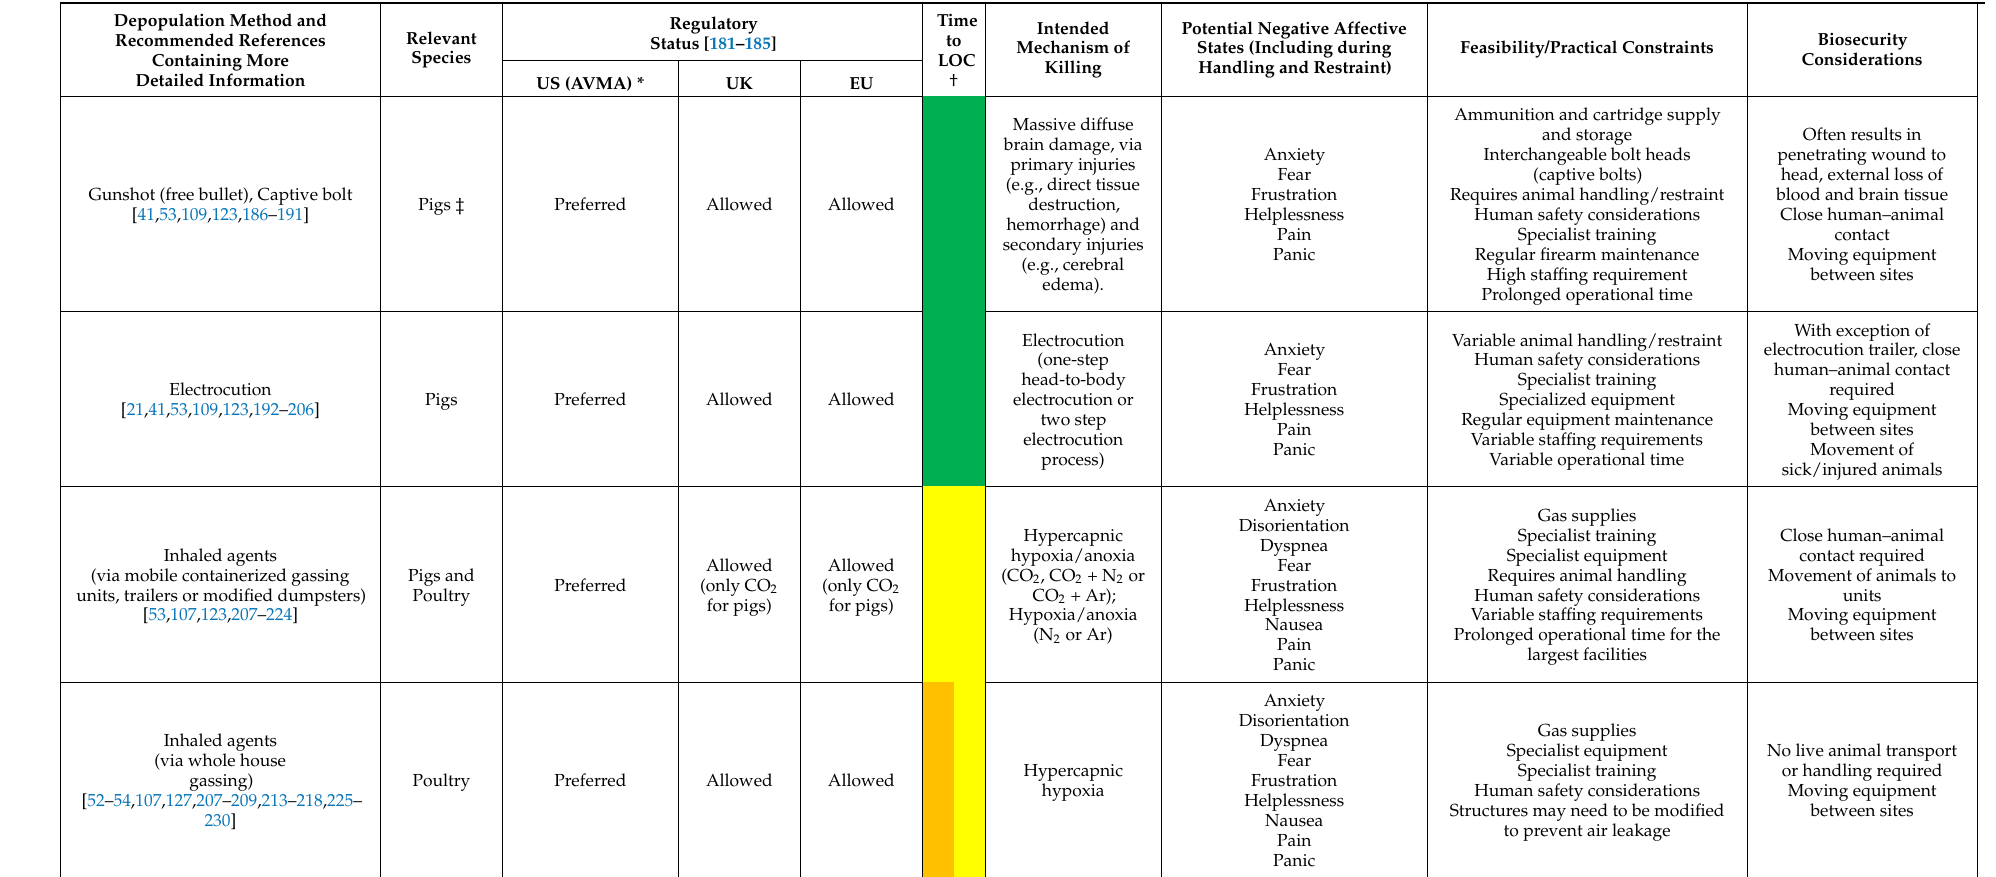
Table A1. Available and potential methods of depopulating pigs and poultry in the United States (US). For each method, information is provided regarding relevant literature and species, regulatory status, animal welfare considerations, feasibility, and biosecurity. Carcass disposal methods and cost associated with method are